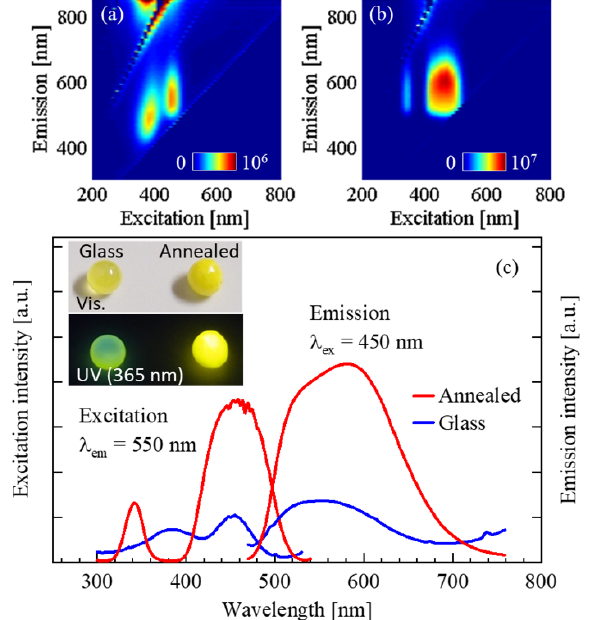
Figure 2. The excitation-emission contour maps ( a ) before and ( b ) after crystallization of the Ce-YAG (yttrium aluminum garnet) glass by annealing at 920 °C for 30 min. The excitation and emission spectra are also shown in ( c ). Insets depict the photographs of the as-prepared Ce-YAG glass and the crystallized Ce-YAG glass, illuminated by visible or ultraviolet (UV) light (365 nm).